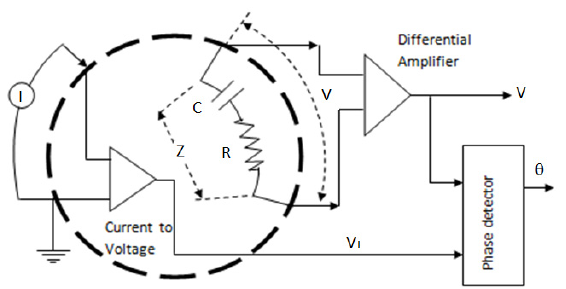
Figure 3. The scheme in the measurement of impedance components separately through a measurement of voltage and phase difference.